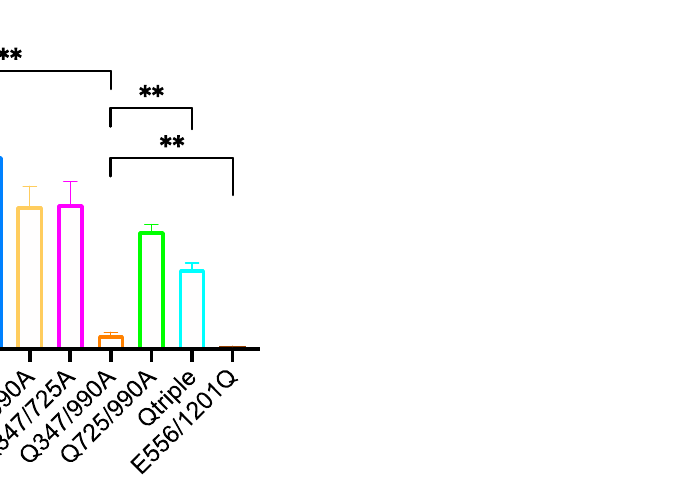
Figure 3. Functionality of glutamine to alanine mutants for the transport of Calcein-AM. Live HEK293T cells transiently expressing equivalent amounts of wild-type (wt) and mutant ABCB1 were challenged with Calcein-AM. Functionality was measured as the ratio of Calcein accumulation (Calcein-AM only becomes fluorescent once it is de-esterified in the cytosol) between the ABCB1- expressing and untransfected cells within the population. This was normalized to 100% for wild-type ABCB1 for the bar graph shown. The mean ± SEM was plotted using GraphPad Prism version 8; sample number was ≥ 3. Selected statistical analysis (ratio of paired Student’s t -test, two-tailed) performed on the raw data is shown with p values: * < 0.05, ** < 0.01. The full pairwise comparison of the data is given in Appendix A Table